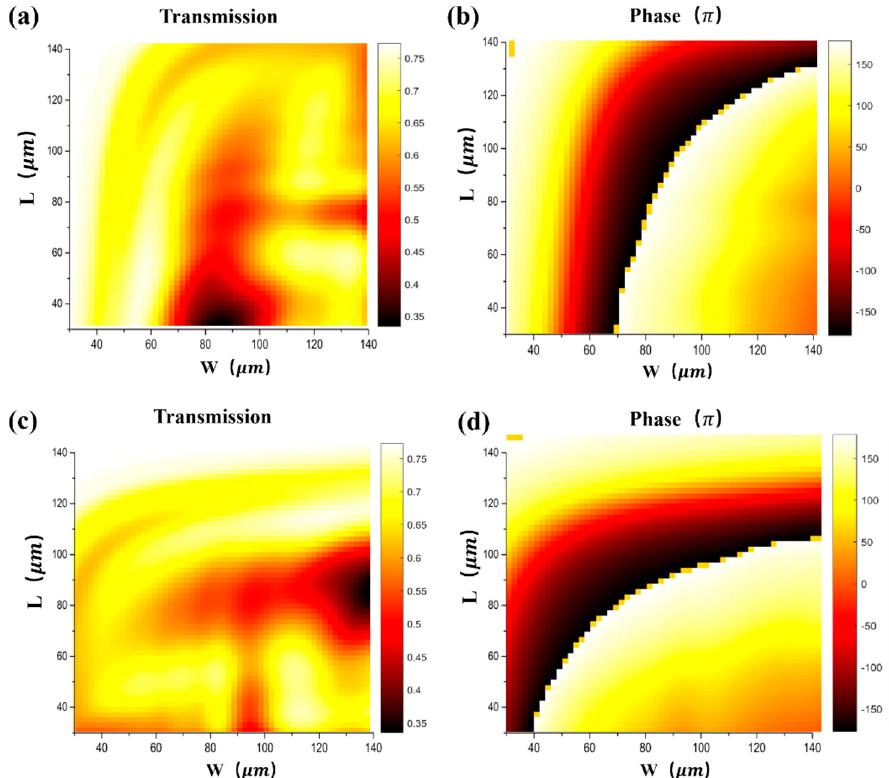
Figure 2. The incident light is perpendicular to the designed unit: ( a – d ) transmission amplitude and phase delay along x − axis ( y − axis) under x − polarized light incidence and y − polarized light incidence at 1 THz.